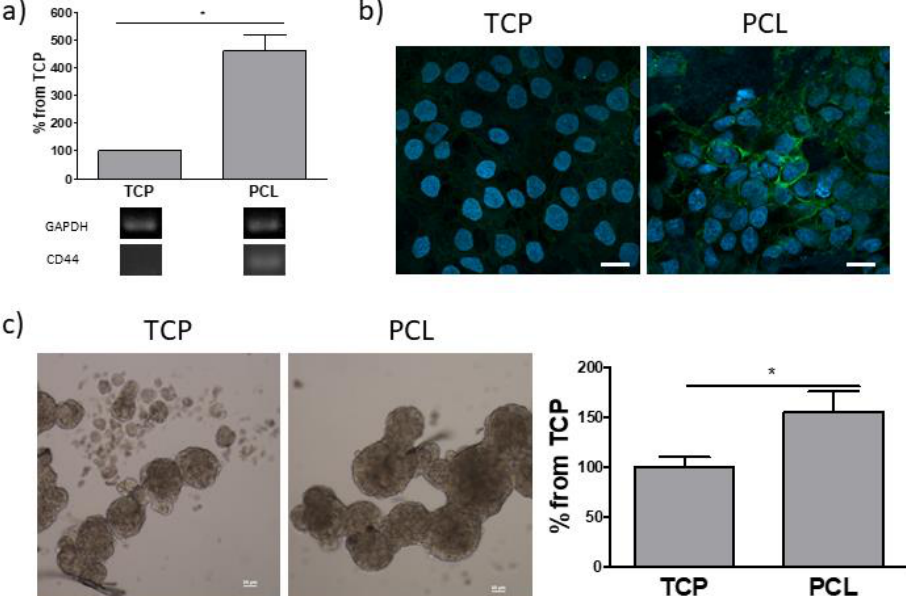
Figure 6. ( a ) RT-PCR analysis of CD44 of cultures grown on tissue-culture polystyrene (TCP), and PCL at 7 days from seeding. Quantification of transcript levels was carried out by densitometric analysis using ImageLab software. Data are reported as the percentage from TCP cultures taken as 100. * p < 0.05 vs. control cultures; Student’s t test. ( b ) Immunofluorescence of CD44: nuclei and CD44-positive areas are blue and green, respectively. Bars: 20 µ m. ( c ) Mammosphere forming assay. Left panel: representative phase contrast micrographs (bars: 50 µ m). Right panel: mammosphere quantification. Data are reported as the percentage from TCP cultures taken as 100. * p < 0.05 vs. control cultures; Student’s t